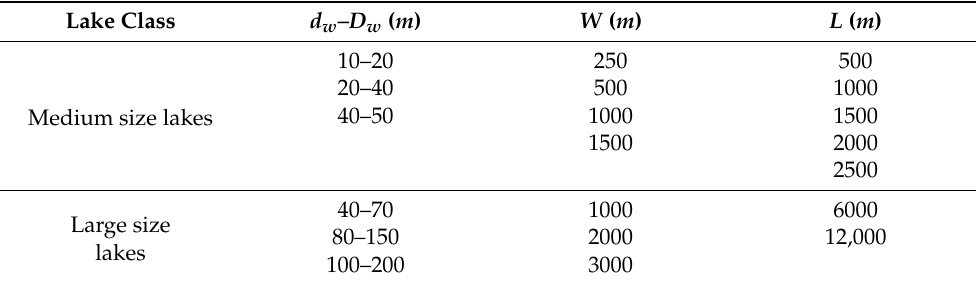
Table 1. Geometry parameters chosen for the theoretical lakes [lake width ( W ), length ( L ), and mean and maximum water depths ( d w and D w )]. Permutations of these three variables yield a total of 69 lake-basin